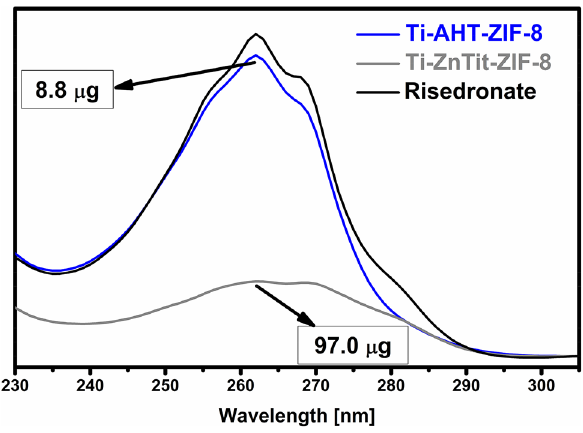
Figure 7. Risedronate sorption after 7 days on the surface of modified Ti6Al4V alloys (“Risedronate” means the starting concentration).